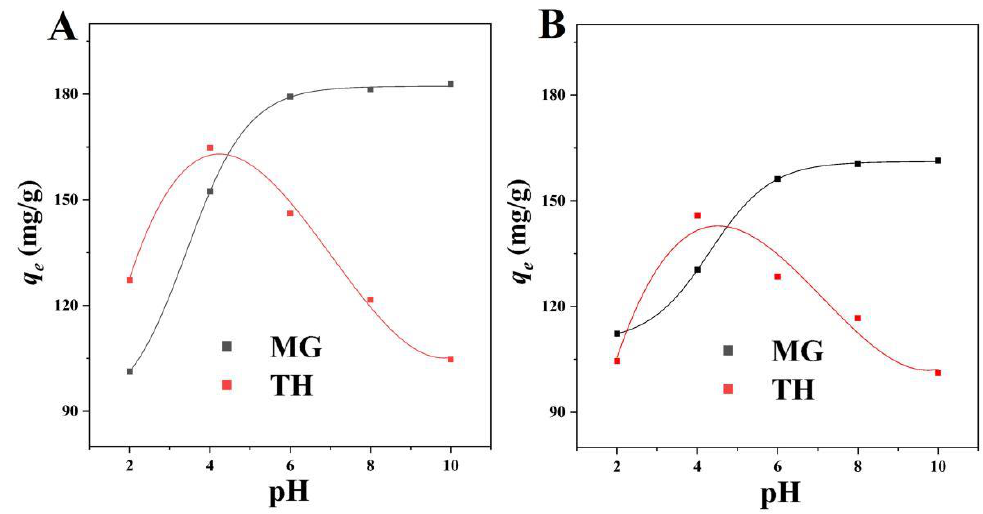
Figure 9. Effect of pH on the adsorption capacities of ( A ) BMFH and ( B ) BMFH/Fe 3 O 4 for MG and TH.